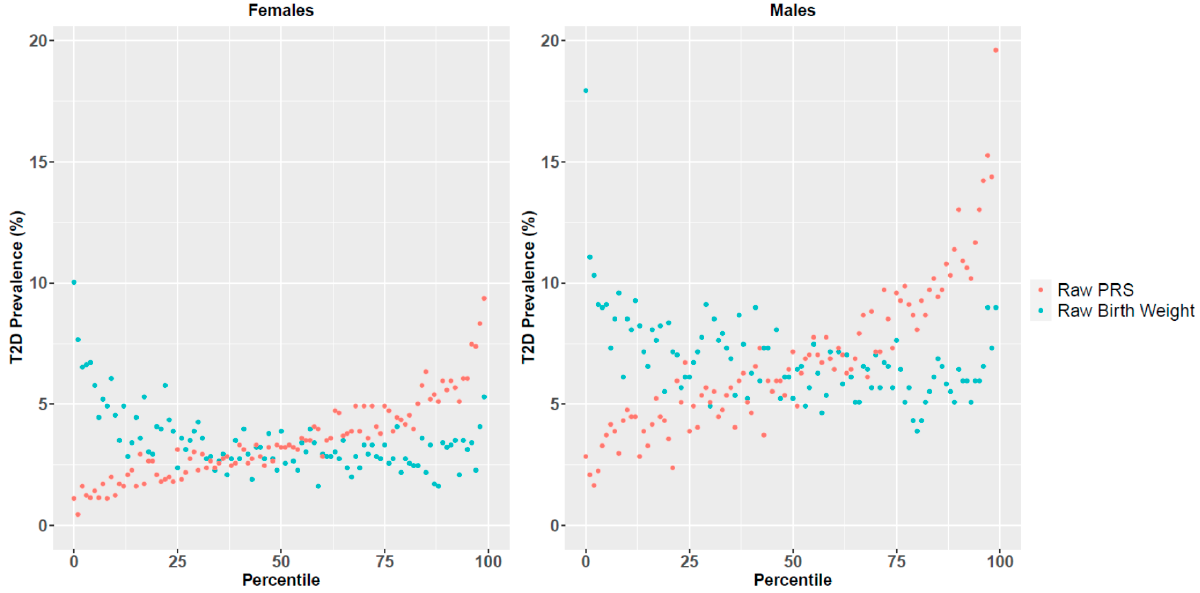
Figure 3. T2D disease prevalence across raw birth weight and PRS percentiles for females and males.